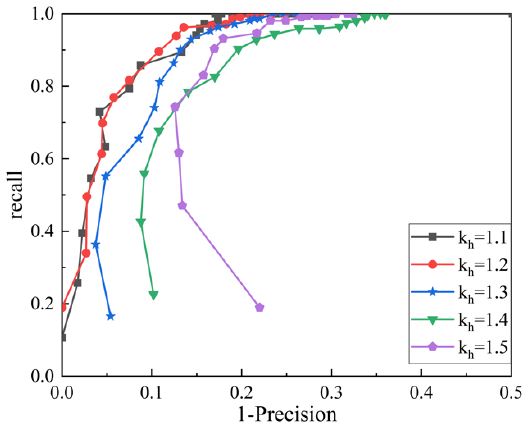
Figure 6. RP curves of different radii of sampling circle.